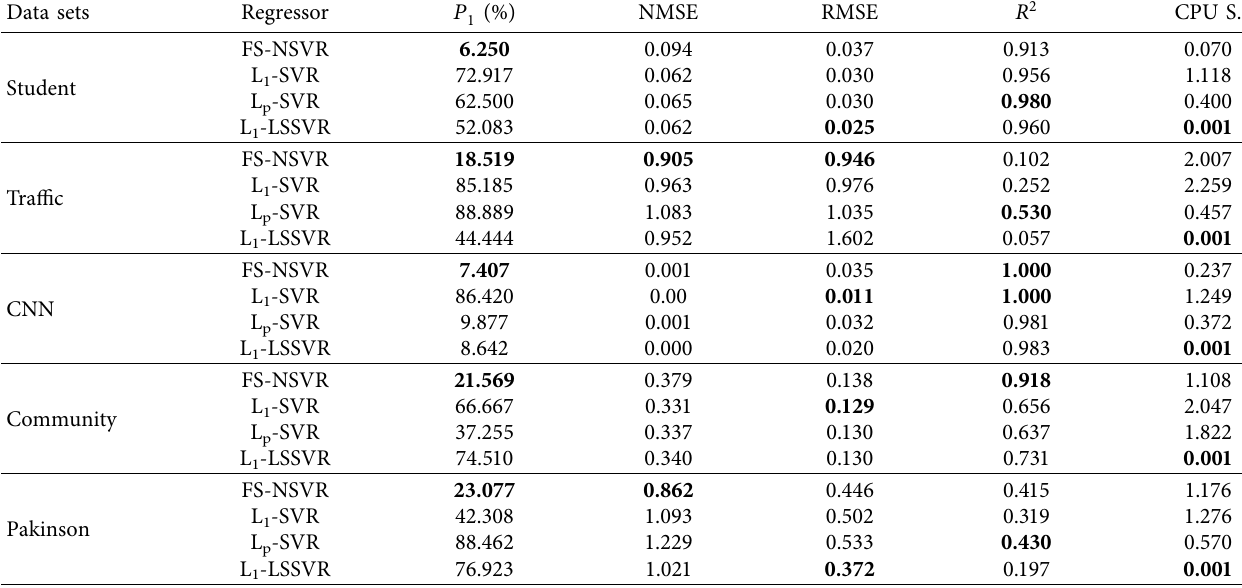
1 -SVR, L p -SVR, and L 1 -LSSVR for real-world datasets.